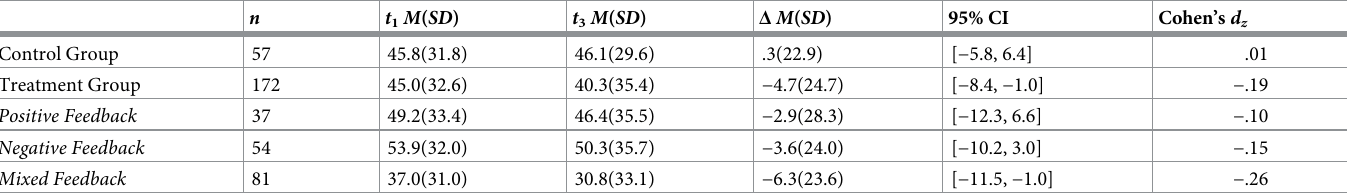
Table 2. Mean values (control vs. treatment groups, t 1 vs. t 3